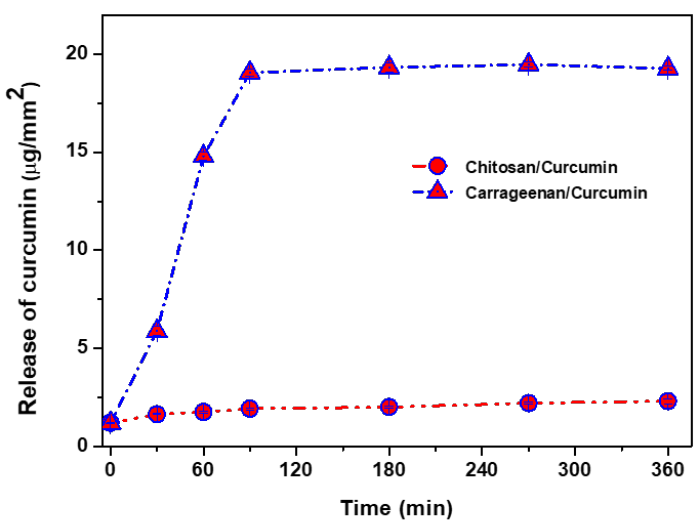
Figure 1. Release of curcumin from the natural biopolymer-based functional films.